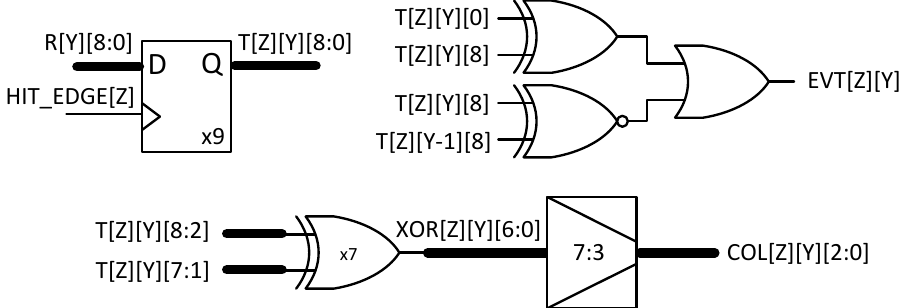
Figure 6. Schematic of the Time Capture Matrix, channel Z, row